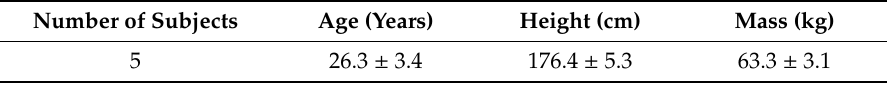
Table 2. Subject information used in this study (mean ± standard